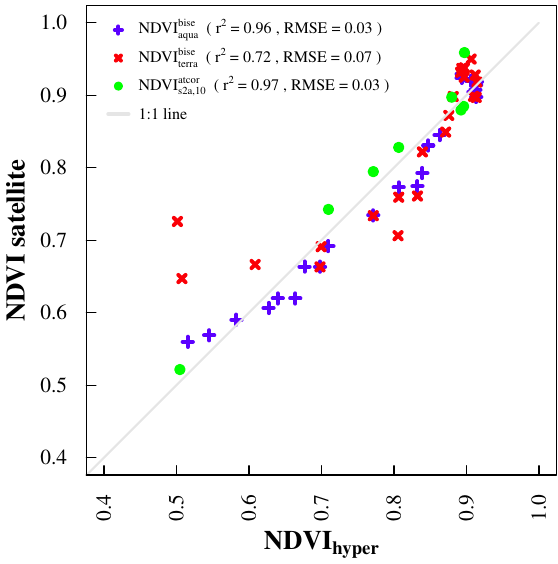
Figure 7. Scatter-plot of NDVI derived from the hyperspectral sensor system ( NDVI hyper ) and satellite NDVI products (NDVI satellite). Satellite NDVI products include NDVI bise aqua (blue), NDVI bise terra (red), as well as NDVI atcor (green). NDVI multi and NDVI atcor are not shown due to large similarities with s2a , 10 s2a , 20 NDVI hyper and NDVI atcor , s2a , 10